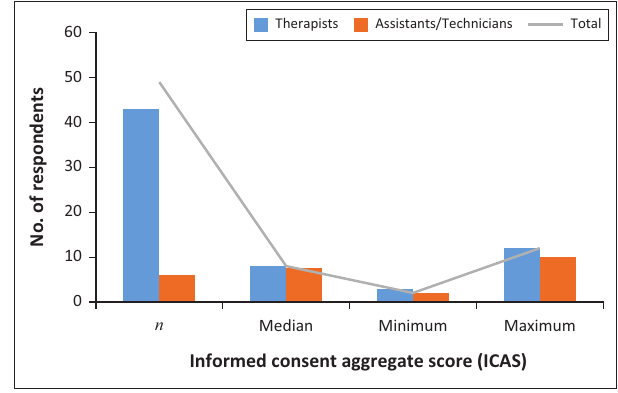
FIGURE 6: Informed consent aggregate score distribution between physiotherapists, physiotherapists’ technicians and physiotherapists’